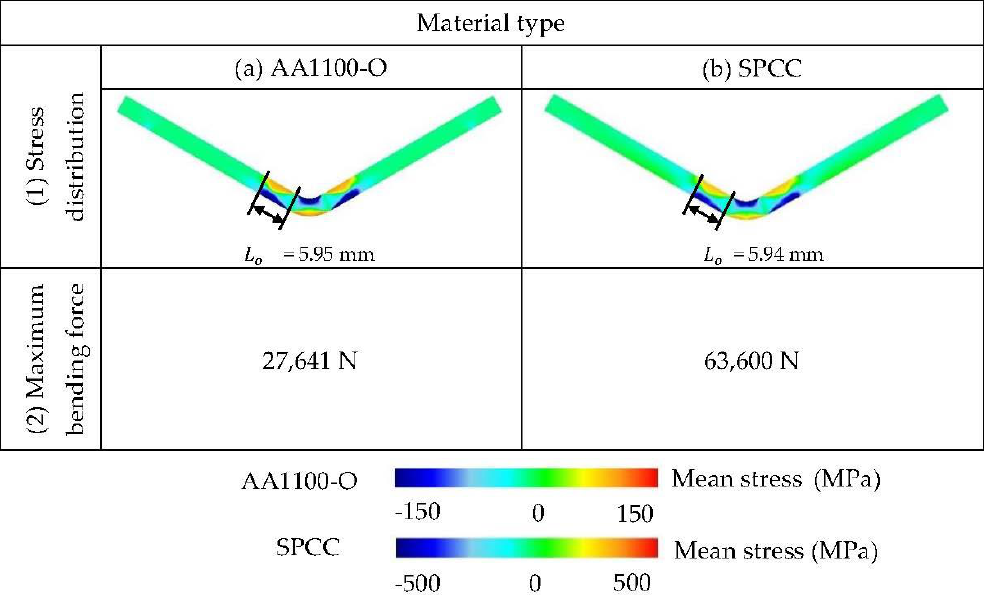
Figure 13. Illustration of stress distribution analyses and bending force predictions with respect to material type ( 𝑅 𝑝 = 3.5 mm, 𝑇 = 3 mm, 𝜃 = 120°, 𝐿 = 70 mm, l k = 60 mm).